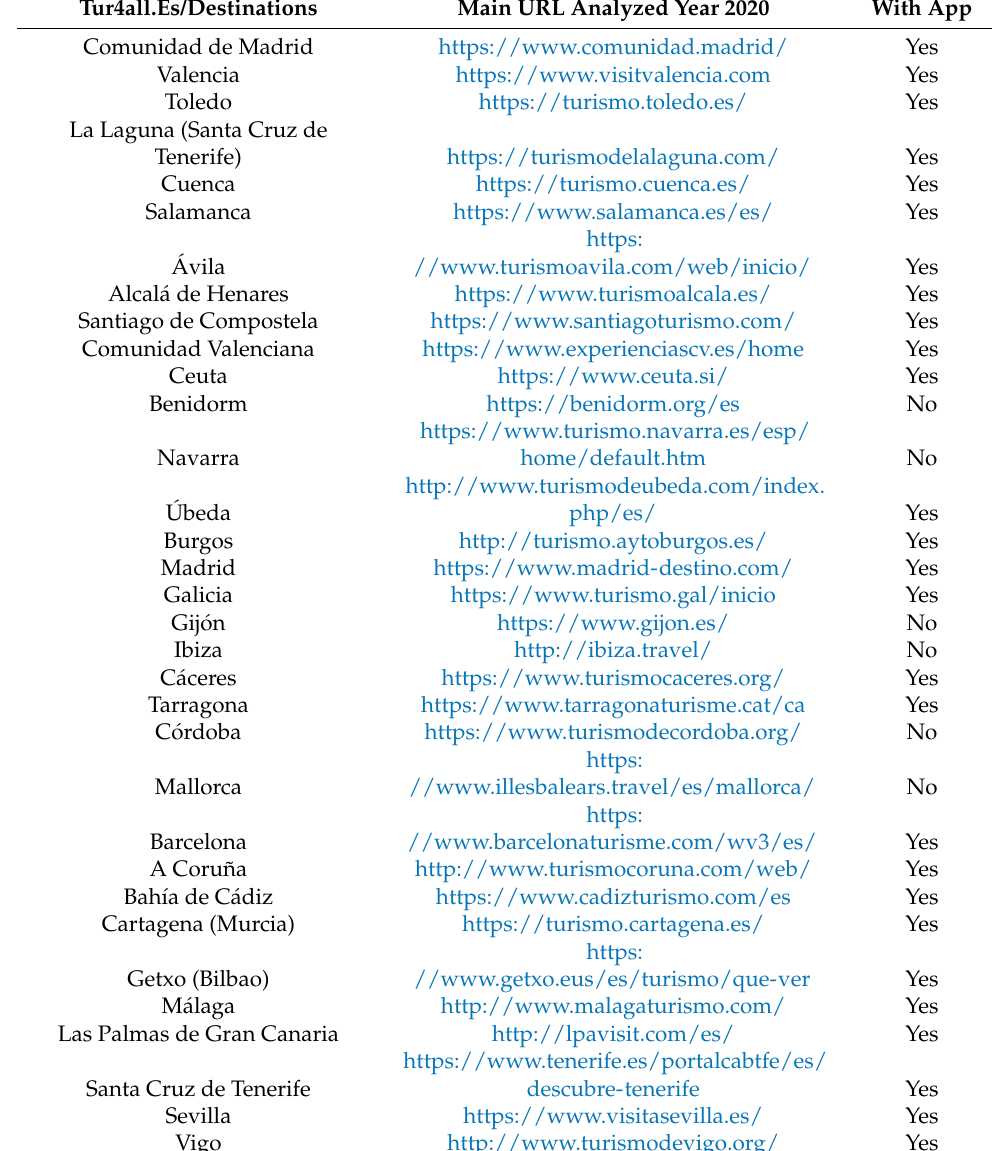
Table A1. Sample of official tourism websites of accessible Spanish destinations shown in Tur4all.es. Tur4all.Es/Destinations